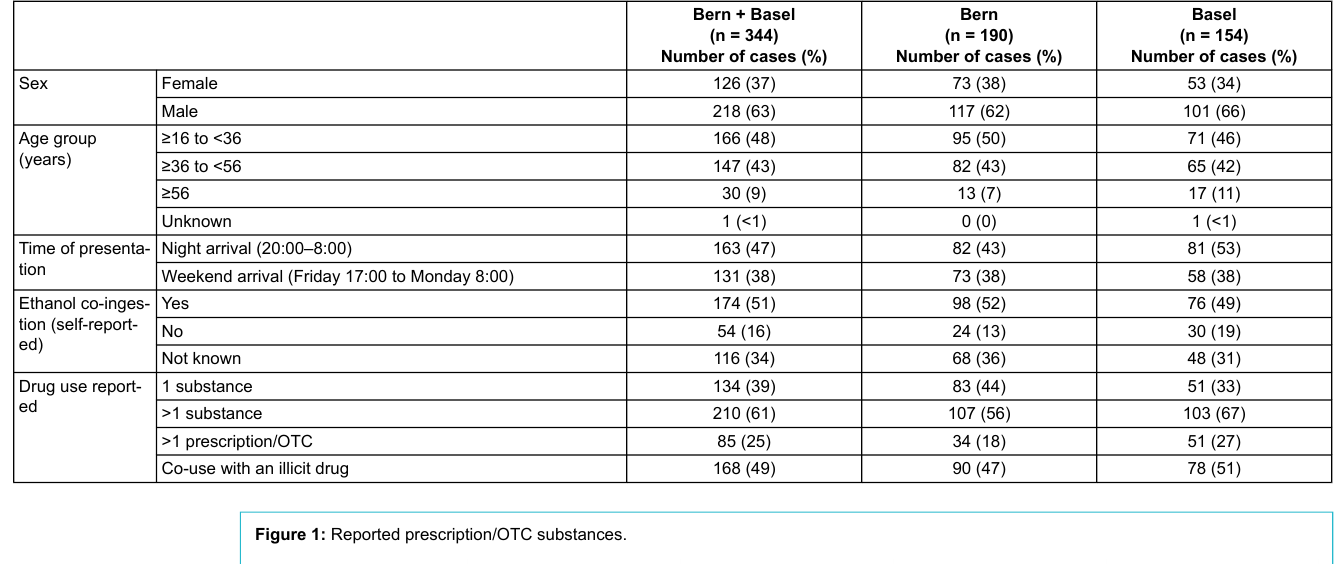
Figure 1: Reported prescription/OTC